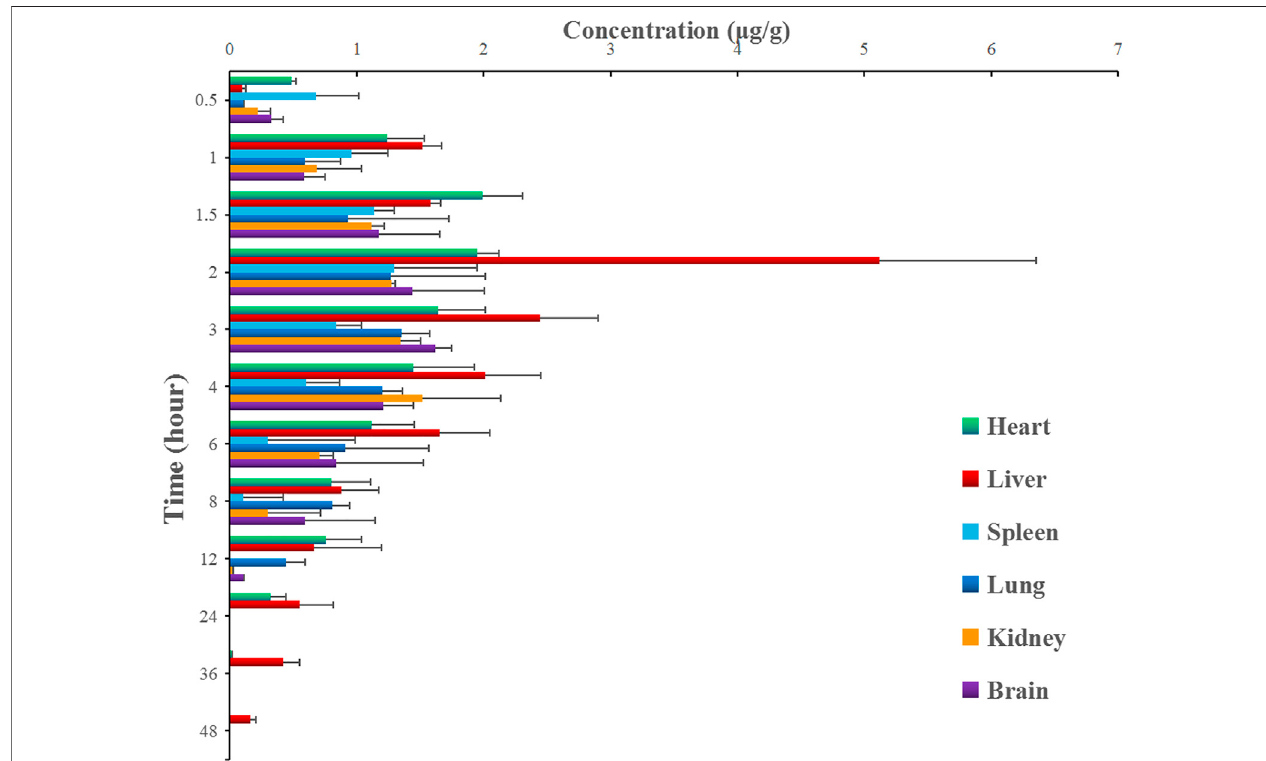
FIGURE 4 | Concentrations of anwulignan in the different tissues of mice after the intragastric administration of anwulignan.